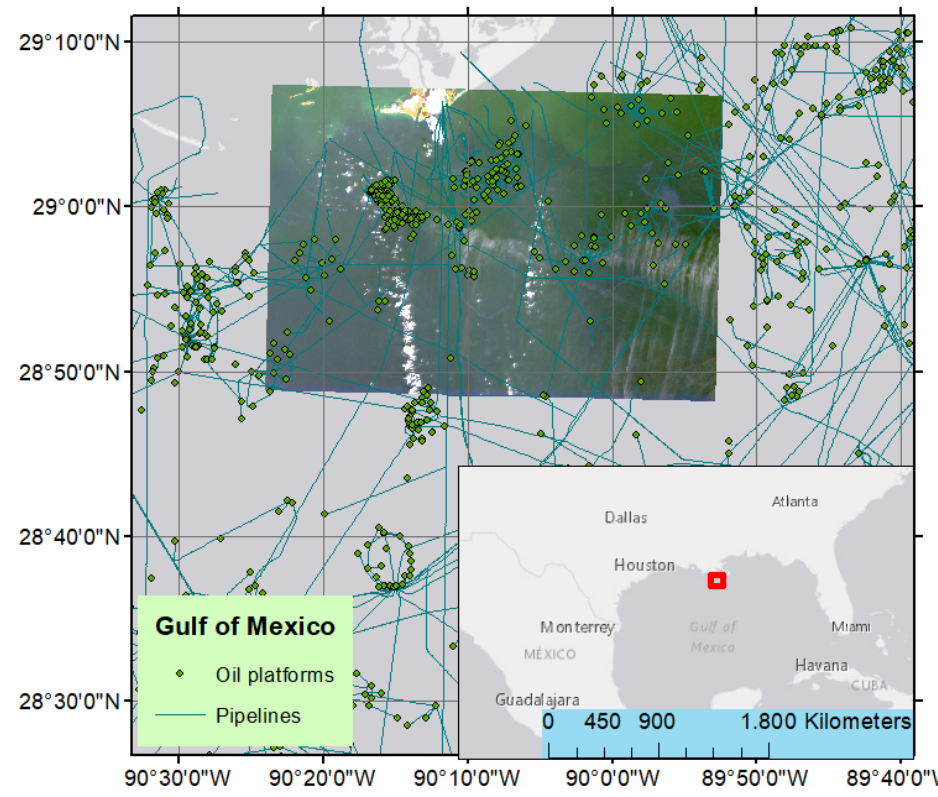
Figure 1. Study area of Port Fourchon oil spill event (The red squares show Gulf of Mexico).